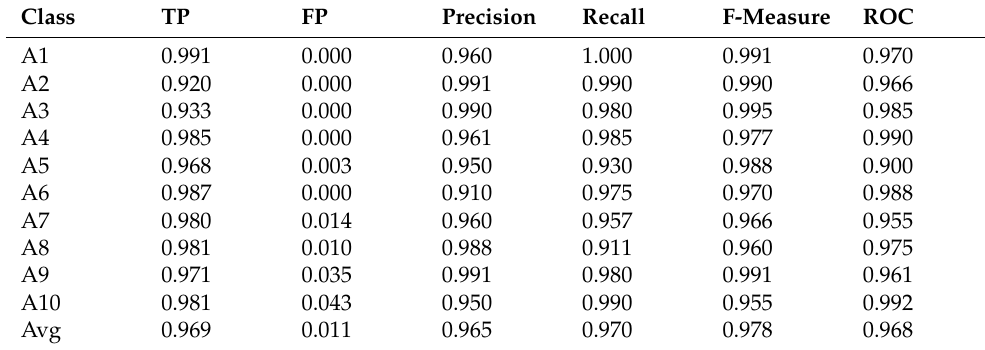
Table 10. DT classification performance.